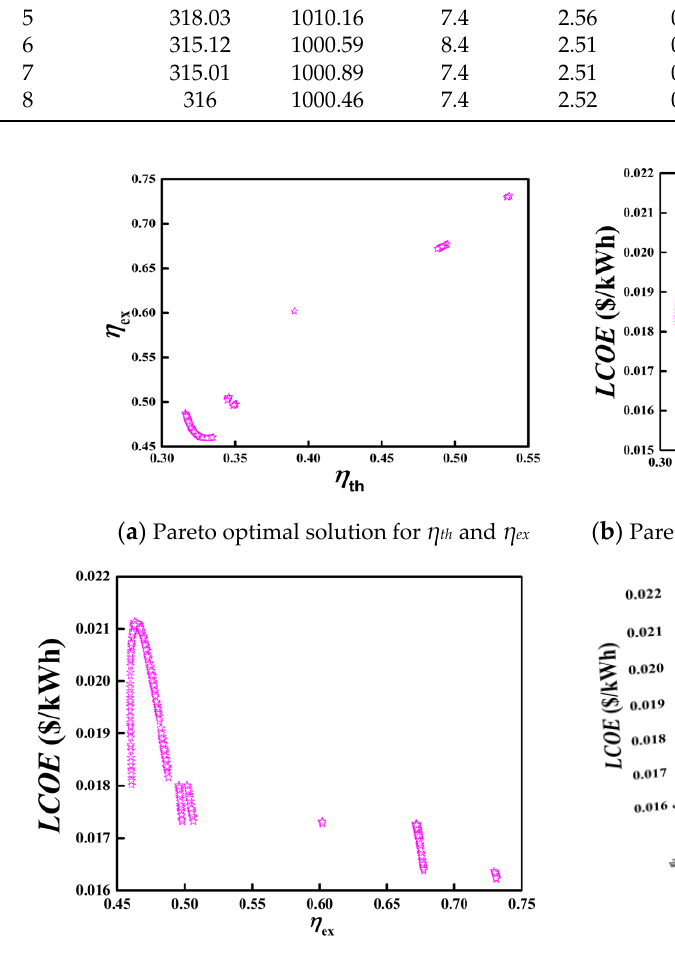
In the three objectives optimization, the initial population size is 1000, the crossover Table 9. Pareto optimal solution for η th , η ex , and LCOE.